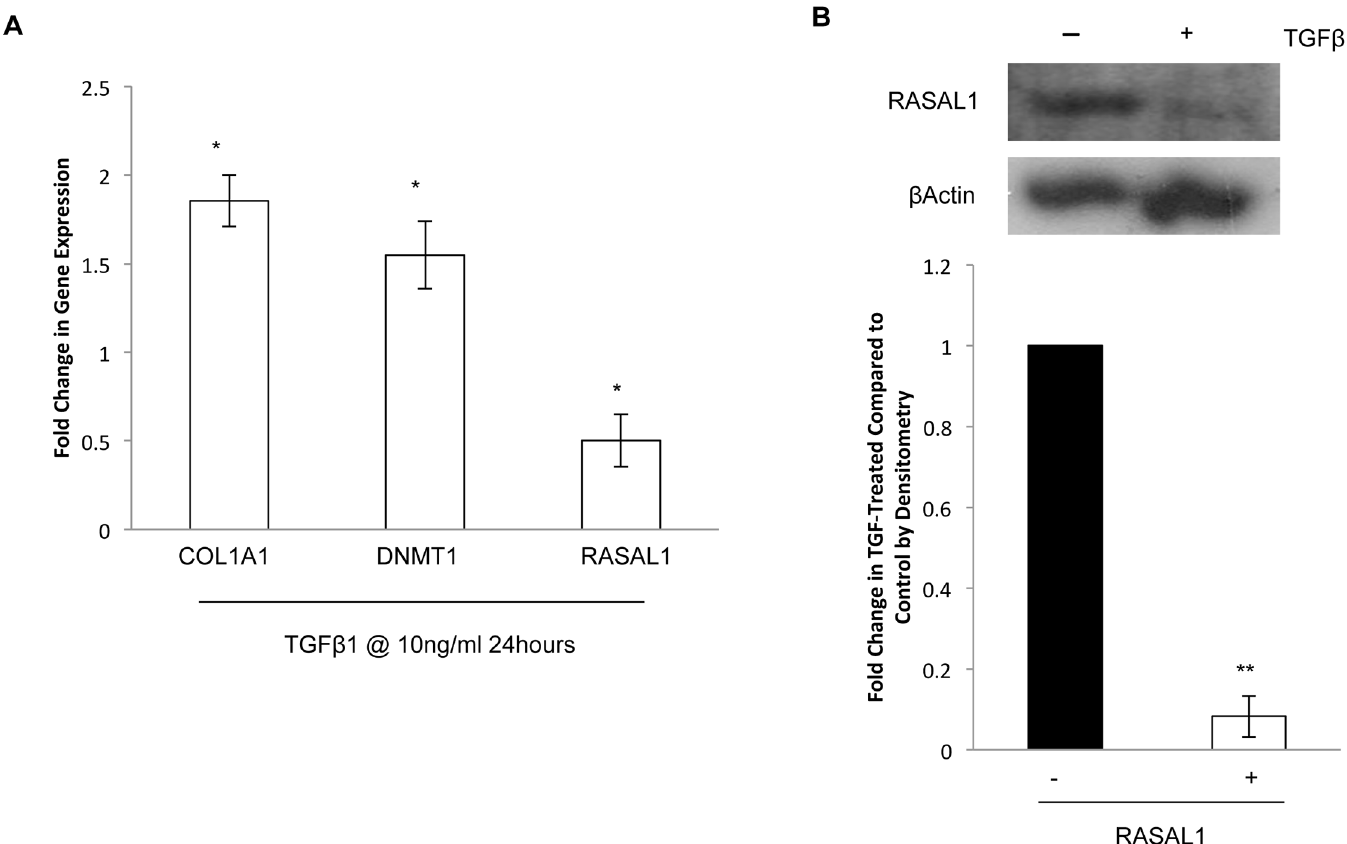
Fig 8. NTM cells treated with TGF β 1 show increased expression of COL1A1 and DNMT1 and decreased expression of RASAL1. We examined the effect of 10ng/ml TGF β 1 on NTM cells after 24 hour treatment. A. There was no significant change in cell viability of cells treated with 10ng/ml TGF β 1. B. Upon investigation of mRNA expression of COL1A1, DNMT1 and RASAL1 by qPCR, we found that COL1A1 (P < 0.05) and DNMT1 were increased and RASAL1 (P < 0.05) was decreased in the cells treated with TGF β 1. C. We examined RASAL1 protein by Western blotting and conducted densitometry on the blots. We found that, like the mRNA expression, TGF β 1 decreased RASAL1 expression in NTM cells. * P < 0.05, ** P < 0.01 Results are from 3 independent